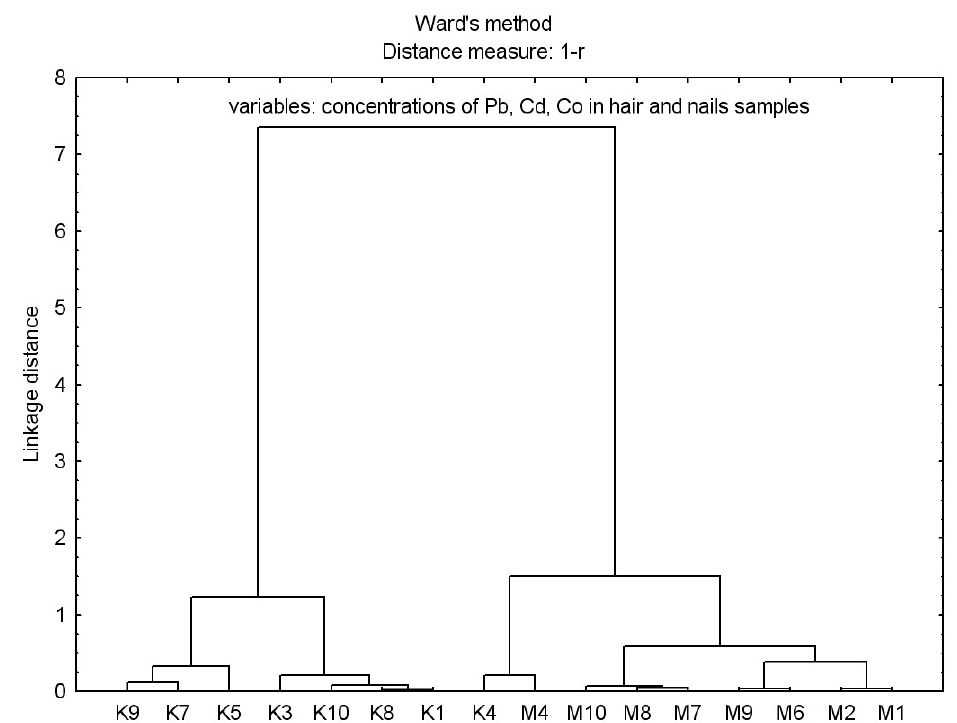
Figure 5. Dendrogram of cluster analysis made on the basis of Ward’s method and 1-r distance for the toxic